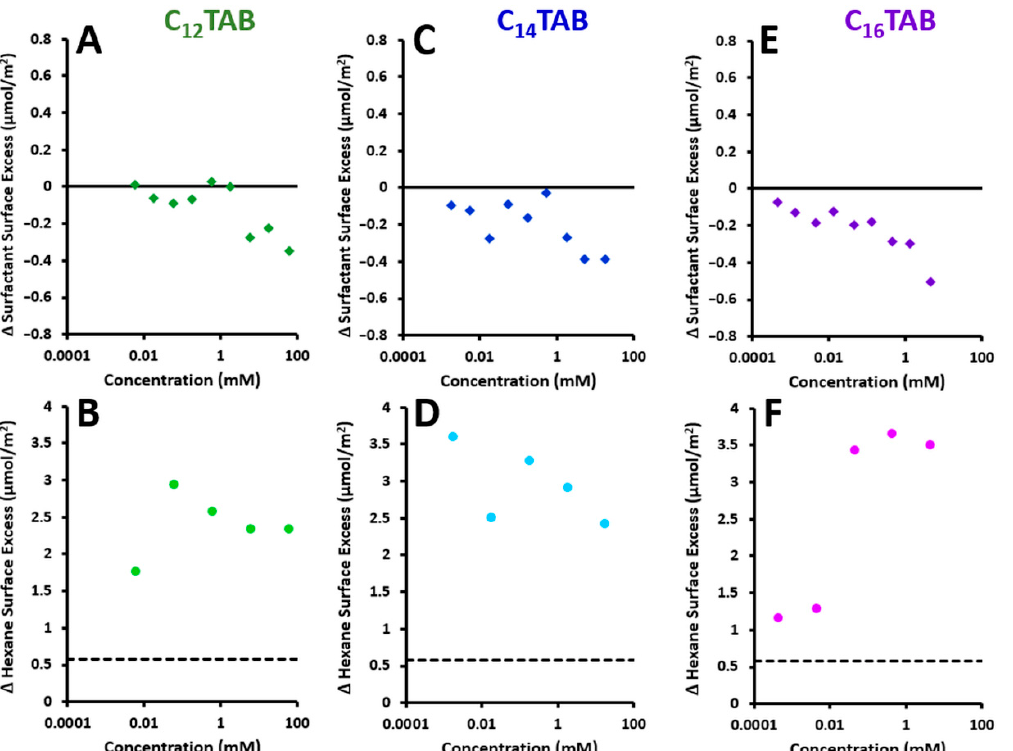
Figure 3. Change in surface excesses of the ( A , C , E ) surfactant and ( B , D , F ) hexane from neutron reflectivity measurements involving ( A , B ) C 12 TAB, ( C , D ) C 14 TAB, and ( E , F ) C 16 TAB. The surfactant values are the averages of the 4 last recorded measurements representing equilibration during the interaction minus the average of the last 4 data points following the venting of the hexane from the sample changer by removing the sealed lids. The hexane values are the average of the 4 last recorded measurements representing sample equilibration during the interaction, an approach to reduce experimental uncertainties through assuming full venting of the hexane. The dashed lines in panels B, D, and F represent the surface excess of hexane adsorbed at a bare water/air interface of 0.57 µ mol/m 2